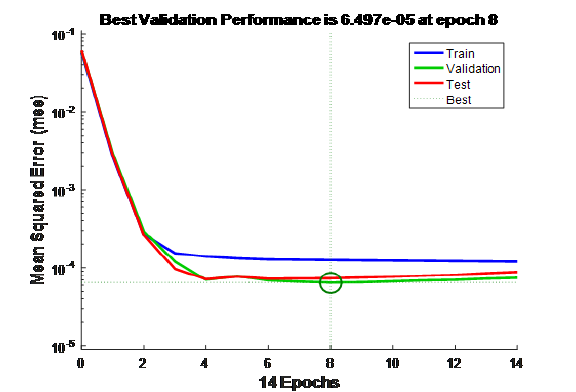
Fig. 4. Performance graph of the neural network after